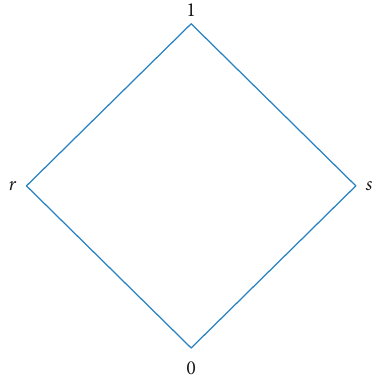
Figure 1: Illustration of k